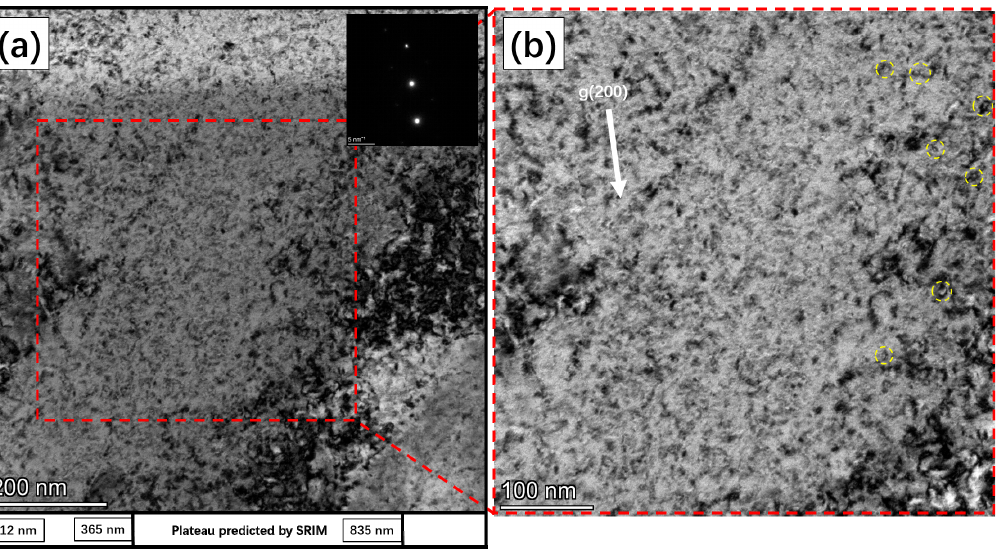
Figure 7. TEM bright field (BF) ( a ) and magnified image ( b ) of RPV steel at plateau damage level of 1.5 dpa predicted by SRIM. The BF images were taken under two-beam BF conditions using a diffraction vector of g = (200) near the [001] zone axis.